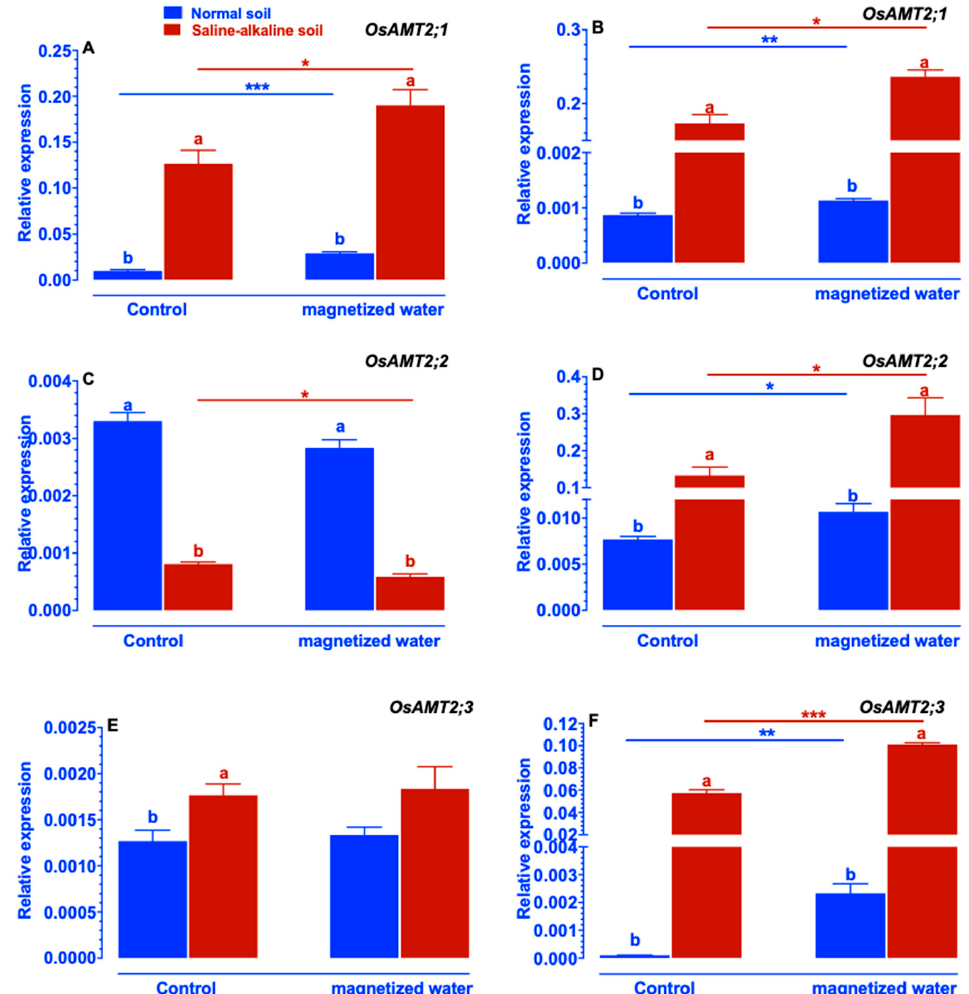
Figure 7. Effects of magnetized water on the expression of the OsAMT2 gene family in Nipponbare seedlings grown in normal and saline–alkaline stress soil: ( A ) OsAMT2;1 in shoot, ( B ) OsAMT2;1 in root, ( C ) OsAMT2;2 in shoot, ( D ) OsAMT2;2 in root, ( E ) OsAMT2;3 in shoot, ( F ) OsAMT2;3 in root. Treatments were as described in Figure 1. Means with different letters are significantly different ( p < 0.05) within the same treatment. Asterisks indicate significant differences between control and saline–alkaline stress of the same genotype, as determined by Student’s t -test (* p < 0.05, ** p < 0.01, *** p < 0.001). Except for OsAMT3;1 (Figure 8A), irrigation with magnetized water increased the expression of OsAMT3;1 , OsAMT3;2 , and OsAMT3;3 in Nipponbare plants growing in both normal and saline–alkaline stress soil (Figure